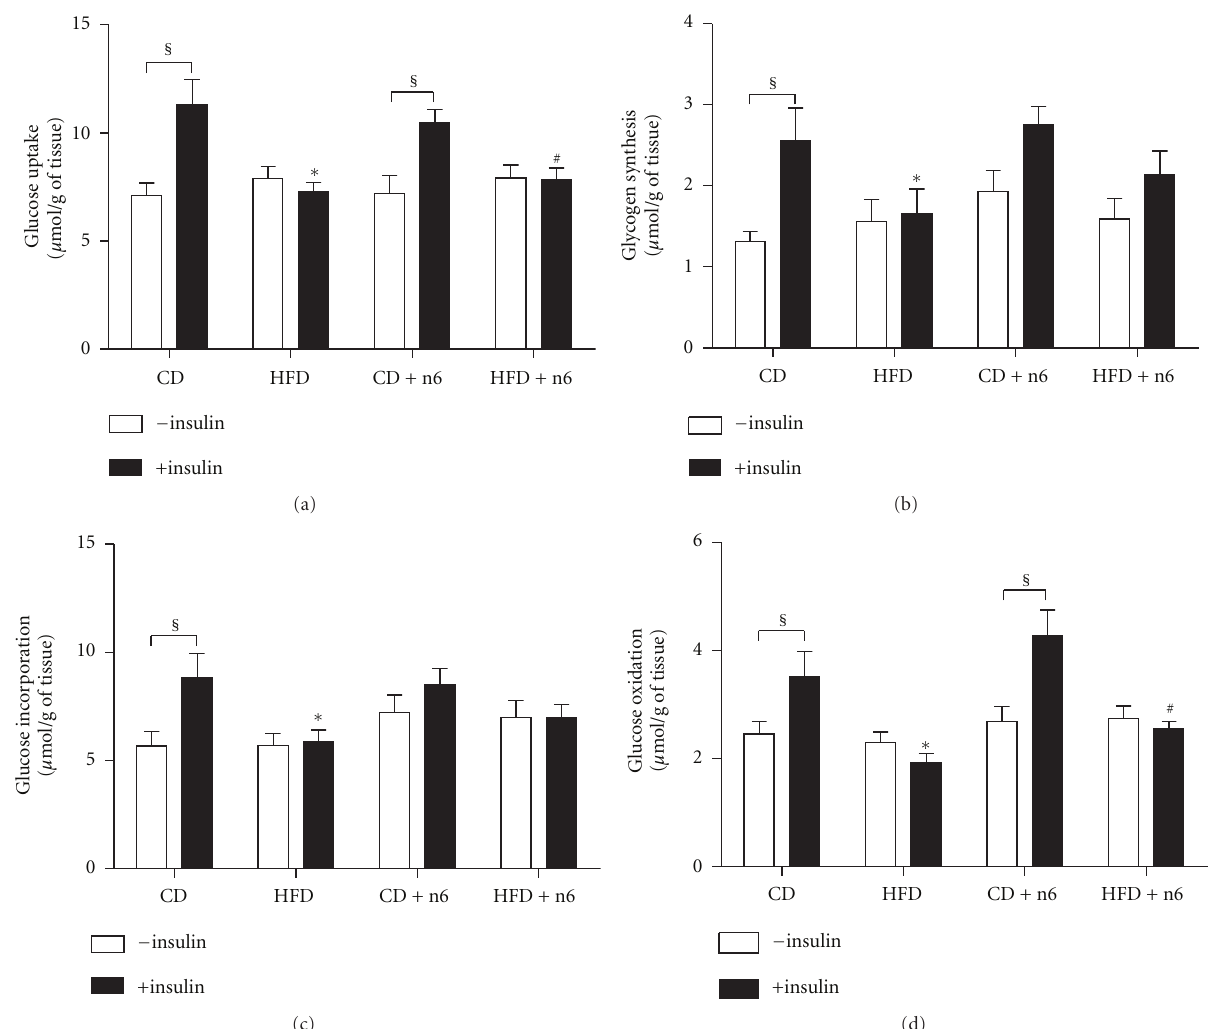
Figure 1: E ff ect of sunflower oil supplementation (rich in n-6 fatty acids) on glucose uptake and metabolism in isolated soleus muscle from C57BL/6 mice. The muscles were incubated in Krebs Ringer bu ff er, containing 5.6mM glucose, 0.3 μ Ci/mL of [U- 14 C]-D-glucose and 0.2 μ Ci/mL of 2-deoxy-[2,6- 3 H]-D-glucose, in the absence (white bars) or presence (black bars) of 7nM insulin, for one hour. At the end